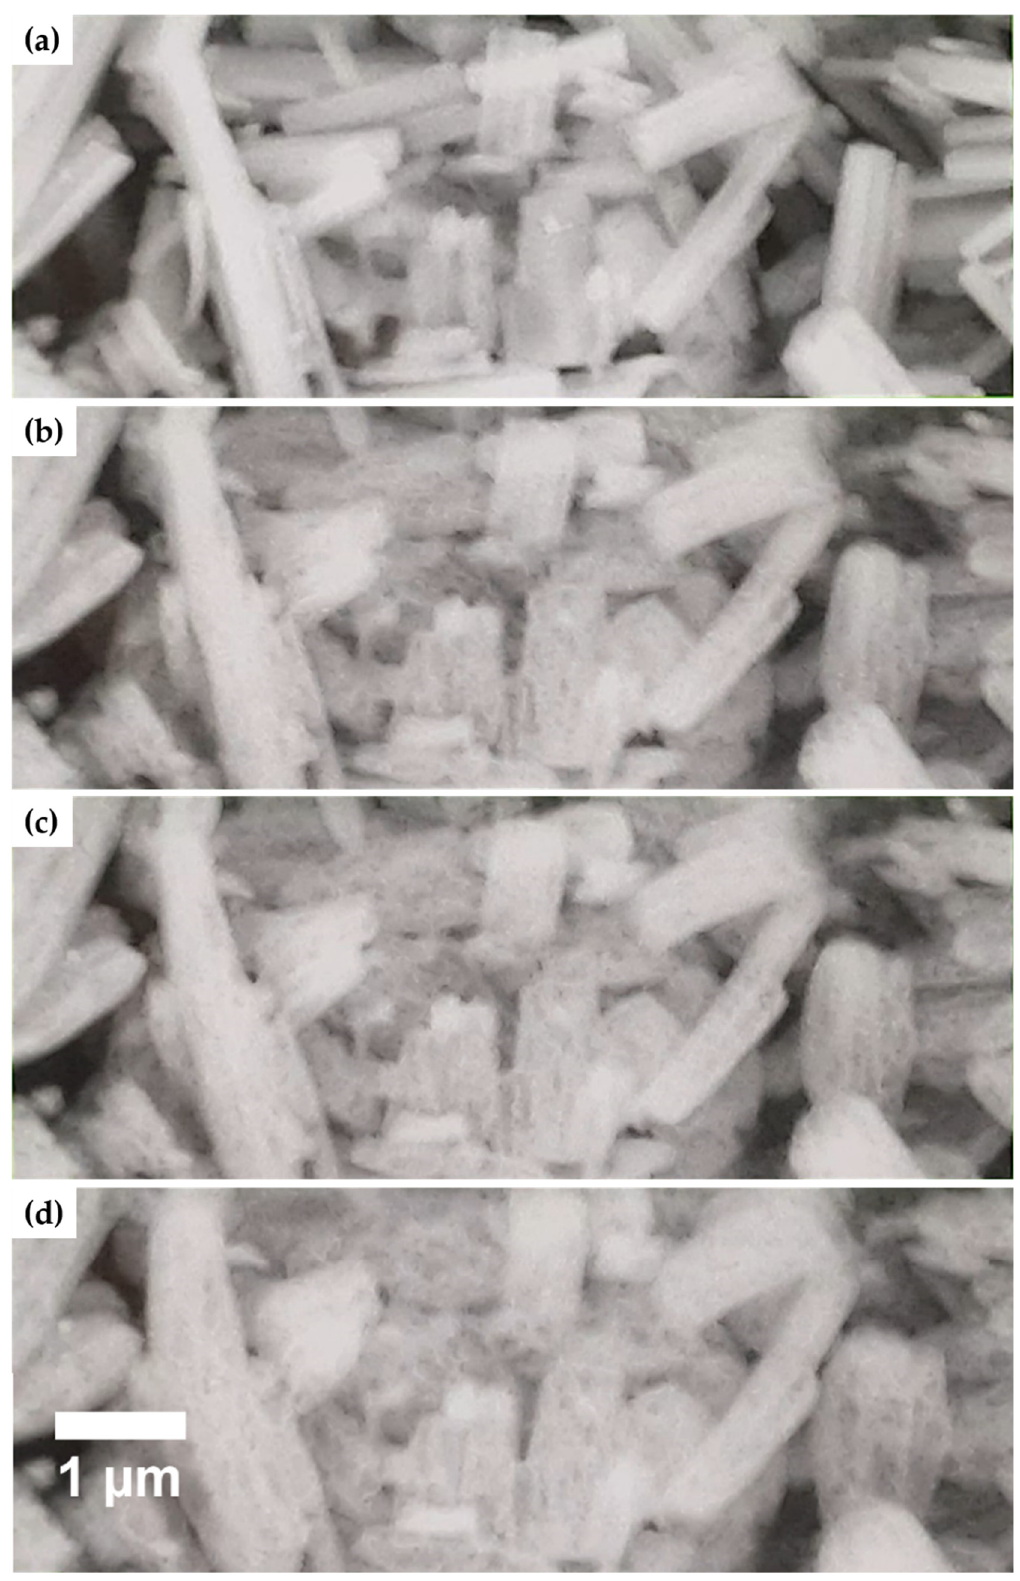
Figure 10. ESEM micrographs of the recorded decomposition of pristine ettringite’s crystals by the electron beam over time; 1 mbar, 10 kV, 6 nA, 10,000 times magnification, 4 s per scan; ( a ) 1 scan, ( b ) 12 scans, ( c ) 23 scans, and ( d ) 33 scans.